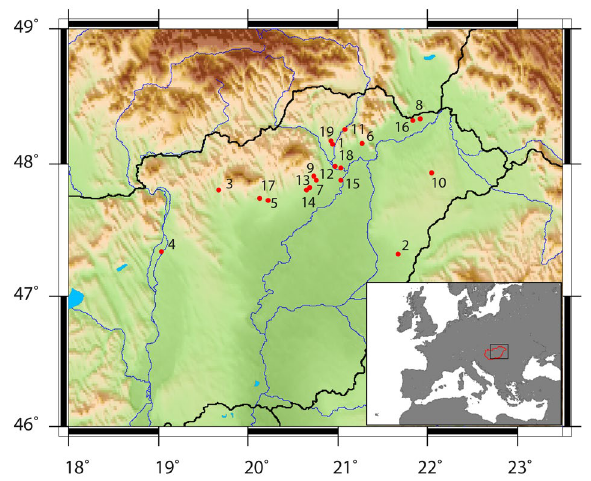
Figure 1. Map showing the location of sites. 1. Ongaújfalu-Állami gazdaság, 2. Konyár-Pocsaji műút, 3. Apc-Berekalja I, 4. Szigetszentmiklós-Üdülősor, 5. Kompolt-Kígyósér, 6. Mezőzombor-Községi temető, 7.